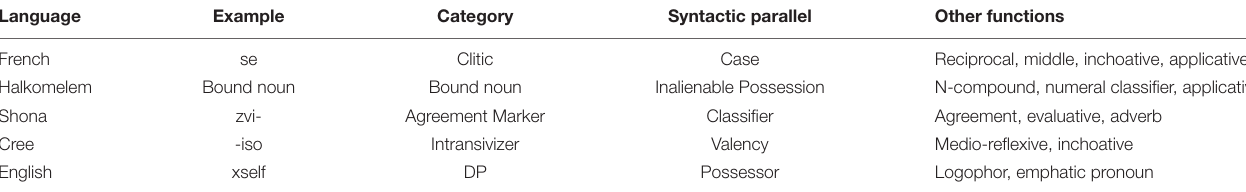
TABLE 2 | Déchaine and Wiltschko’s (2017) typology of reflexives. Language